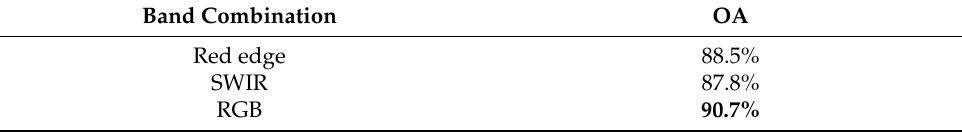
Table 9. OA of SAR and optical data fusion.